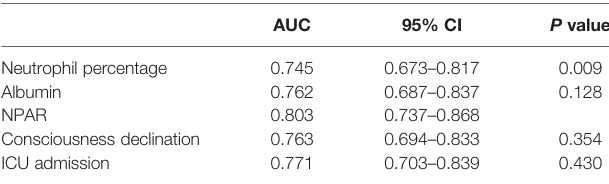
TABLE 3 | Comparison of AUC values between NPAR and other factors in assessing severity at admission.